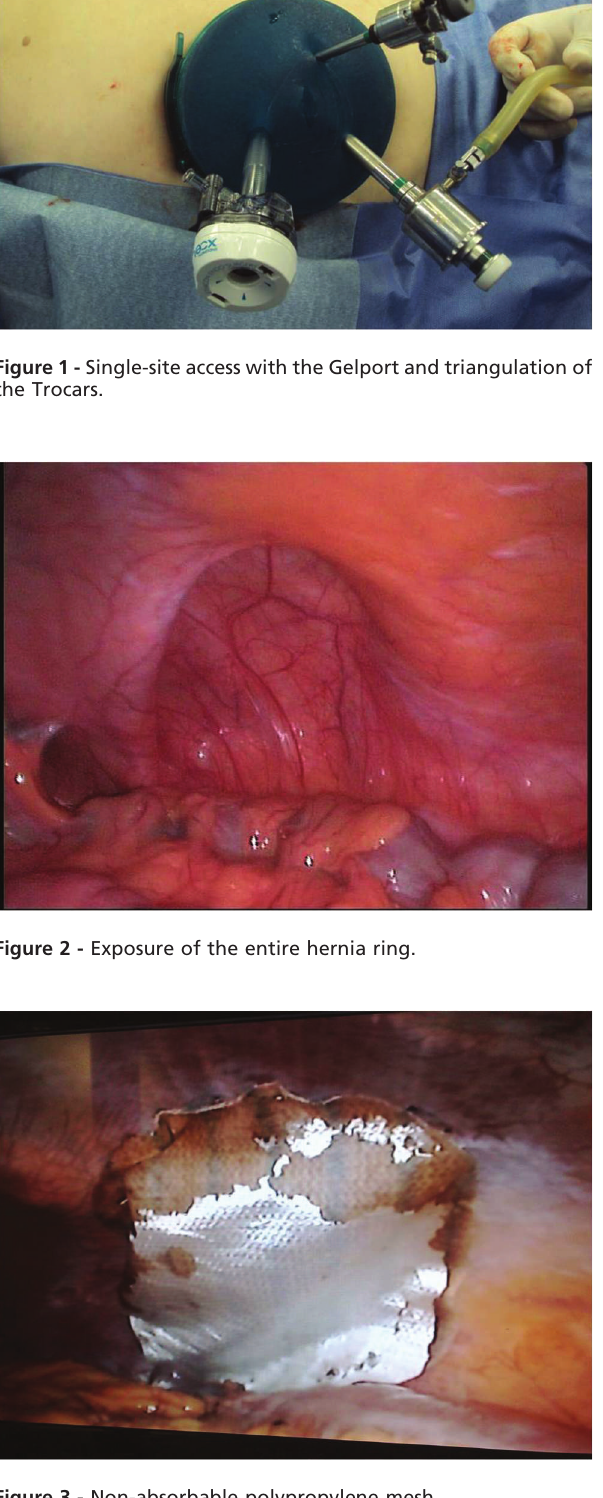
Figure 3 - Non-absorbable polypropylene mesh.